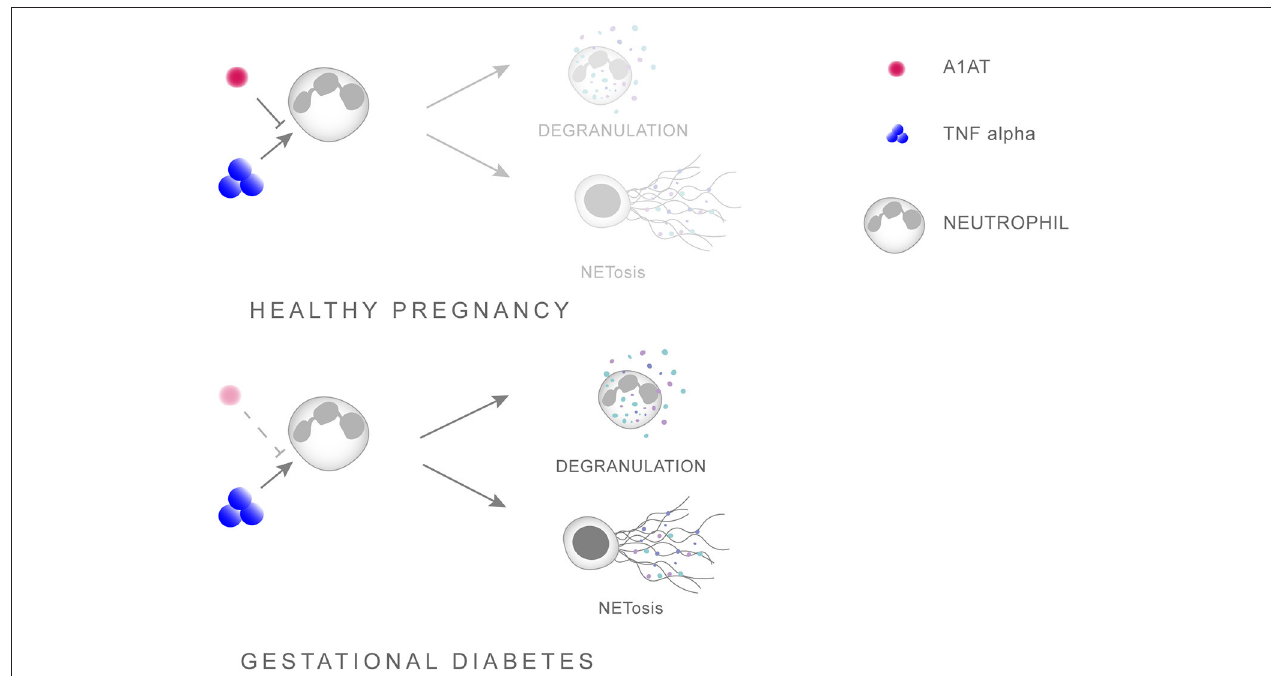
FIGURE 1 | Scheme illustrating the interaction between A1AT and TNF α in regulating neutrophil priming. A1AT hinders the ability of TNF α to interact with its receptor, thereby reducing the extent of neutrophil priming and subsequent degranulation. In GDM this system is skewed in favor of overt neutrophil priming due to enhanced TNF α levels concomitant with reduced A1AT concentrations.